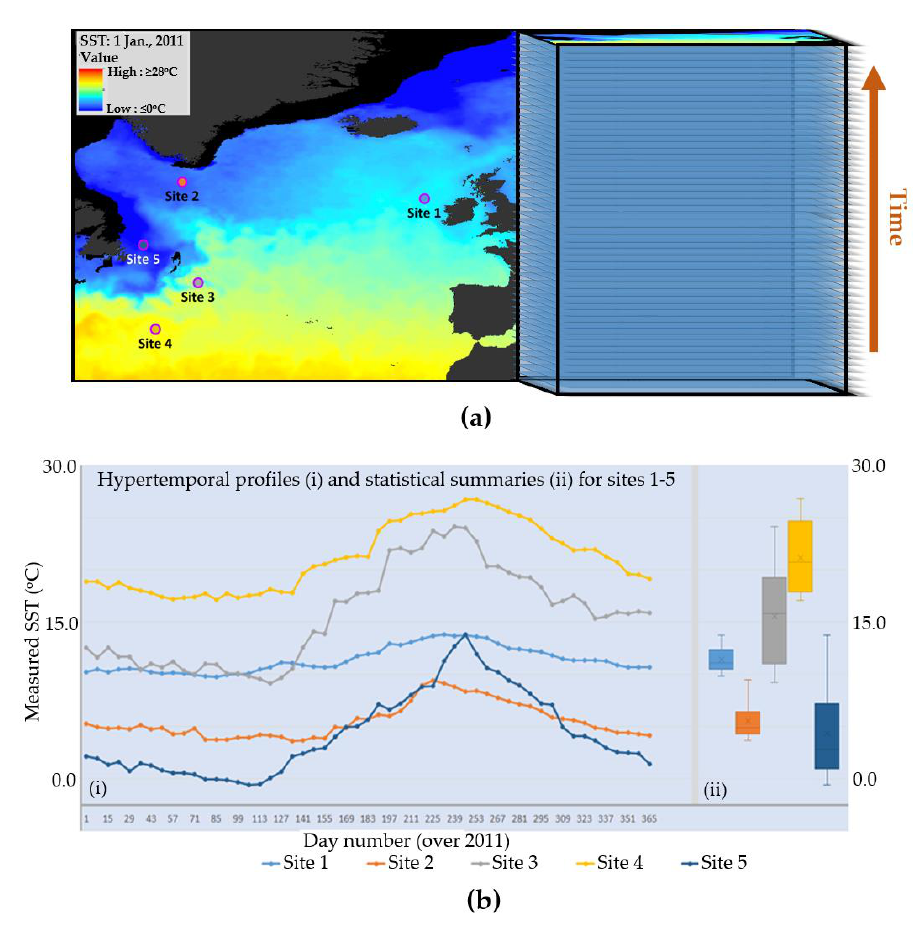
Figure 4. Example hypertemporal datacube of GHRSST level-4 sea surface temperature data for the North Atlantic, showing potential distinct signature features and the potential for simple statistical summaries. ( a ) Sample image from the 1 January 2011, showing the dataset extent, and coupled with a 3D representation of the temporal datacube. The locations of sites 1 to 5 from which temporal signatures were extracted are indicated. ( b ) The temporal signatures from example sites 1–5, coupled with box plot statistical summaries of their values.